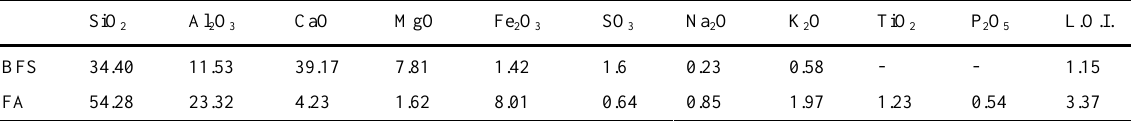
Table1: Chemical compositions of fly ash and blast furnace slag deduced from X-ray fluorescence and expressed in mass%. SiO 2 Al 2 O